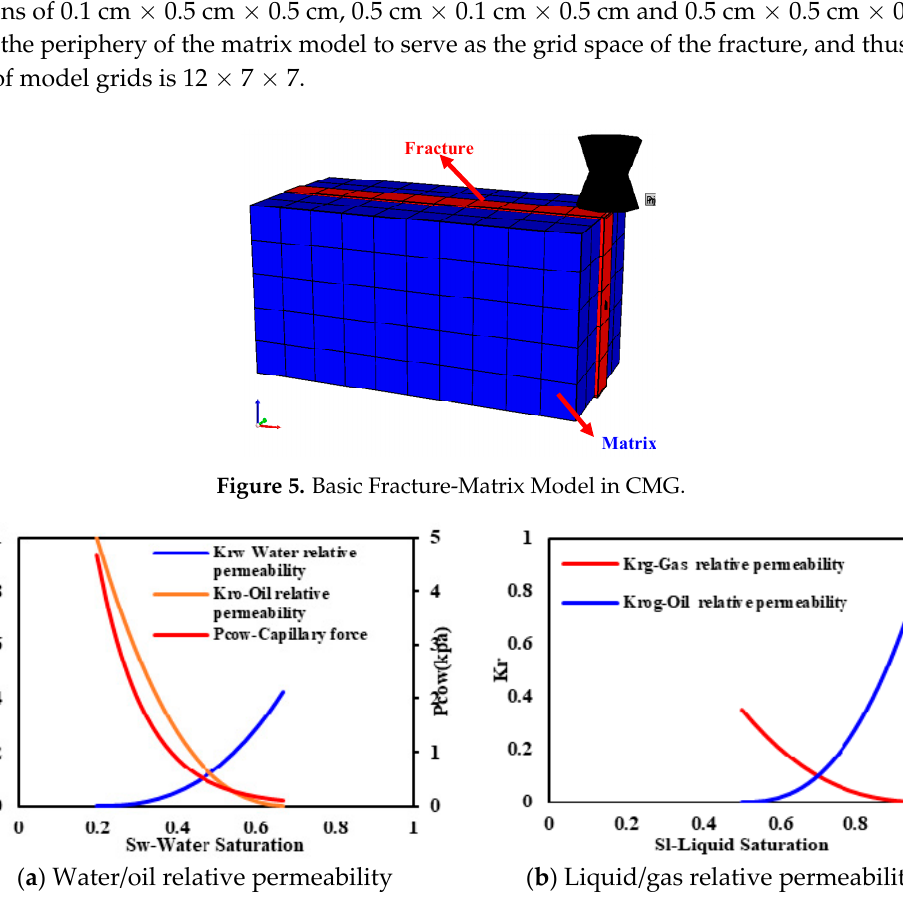
Figure 7. Relative permeability curve of the fracture.